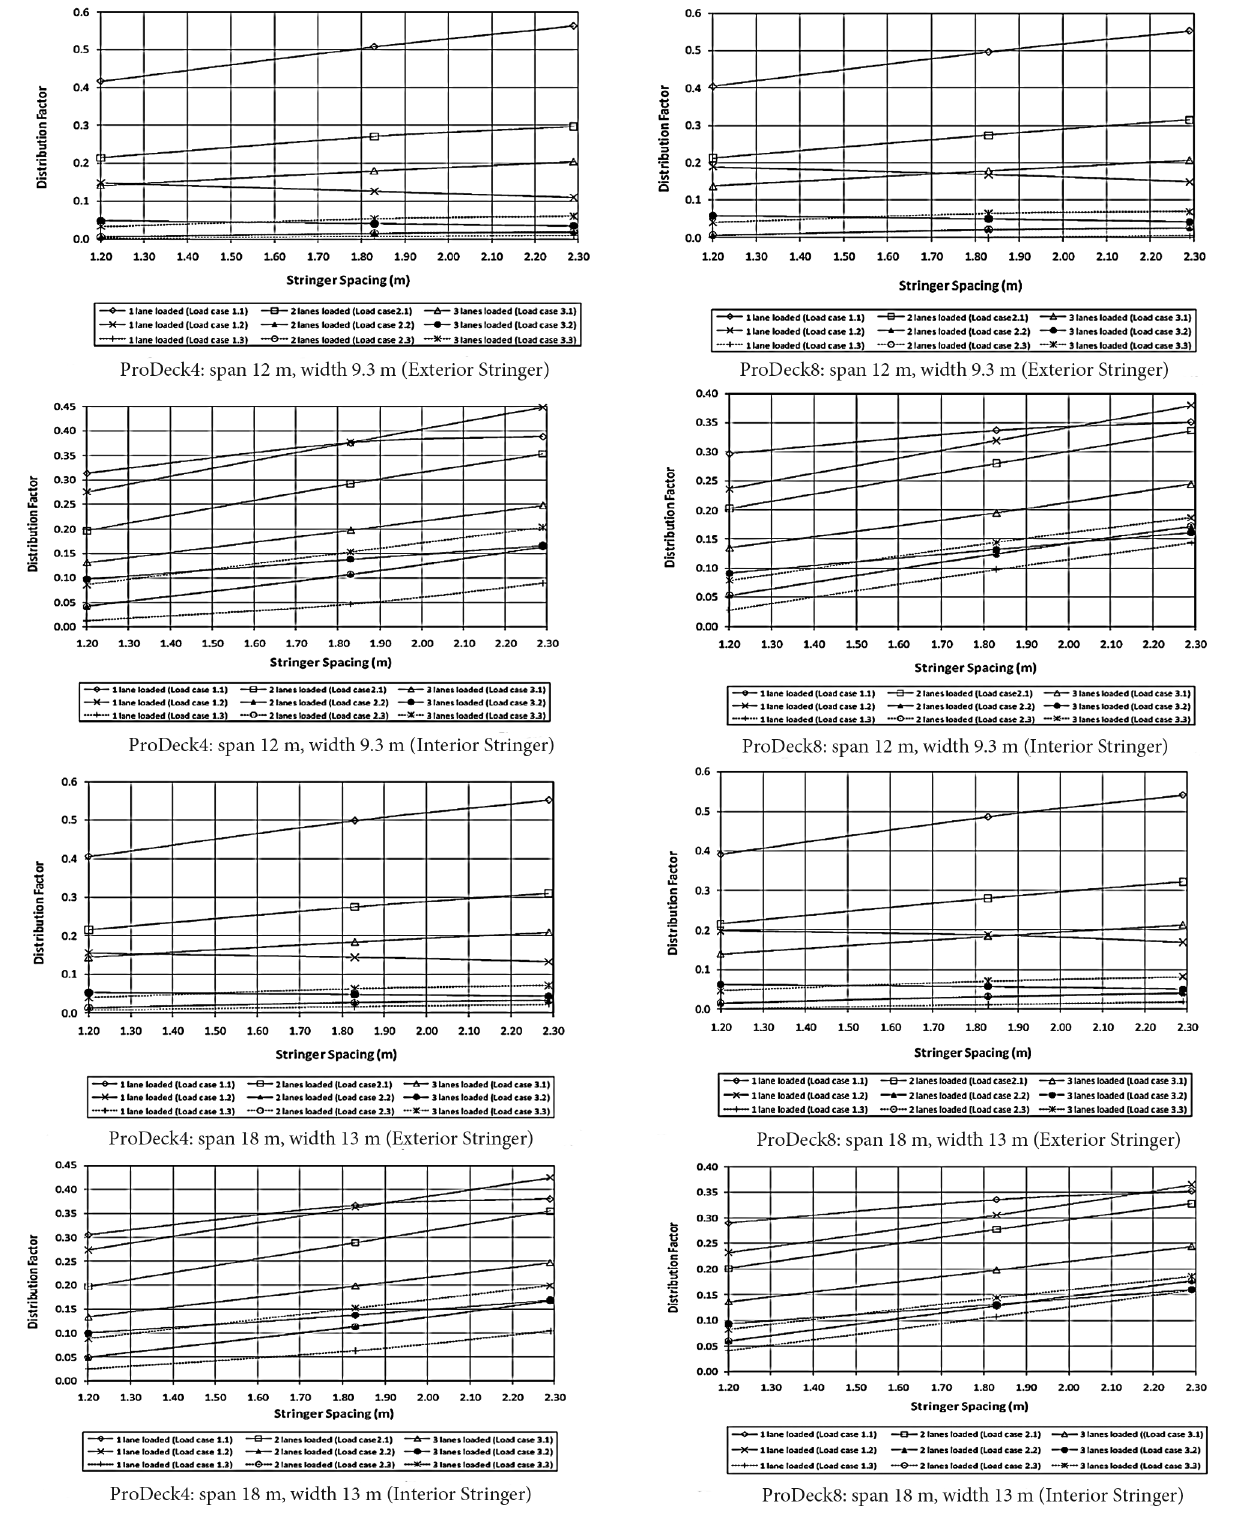
Fig. 6. Load distribution factors for ProDeck 4 and ProDeck 8 – stringer bridge